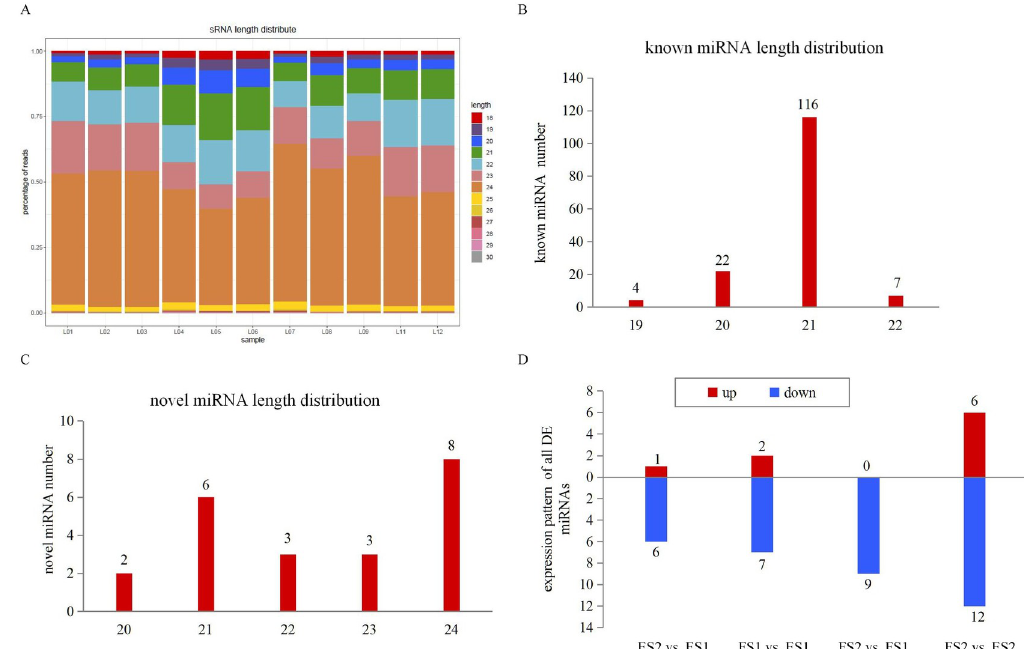
Fig 7. Size distribution of miRNAs by sRNA-seq. (A) Length distribution of sRNAs. (B) Numbers of length distribution of known miRNAs. (C) Numbers of length distribution of novel miRNAs. (D) Expression pattern of DE miRNAs.